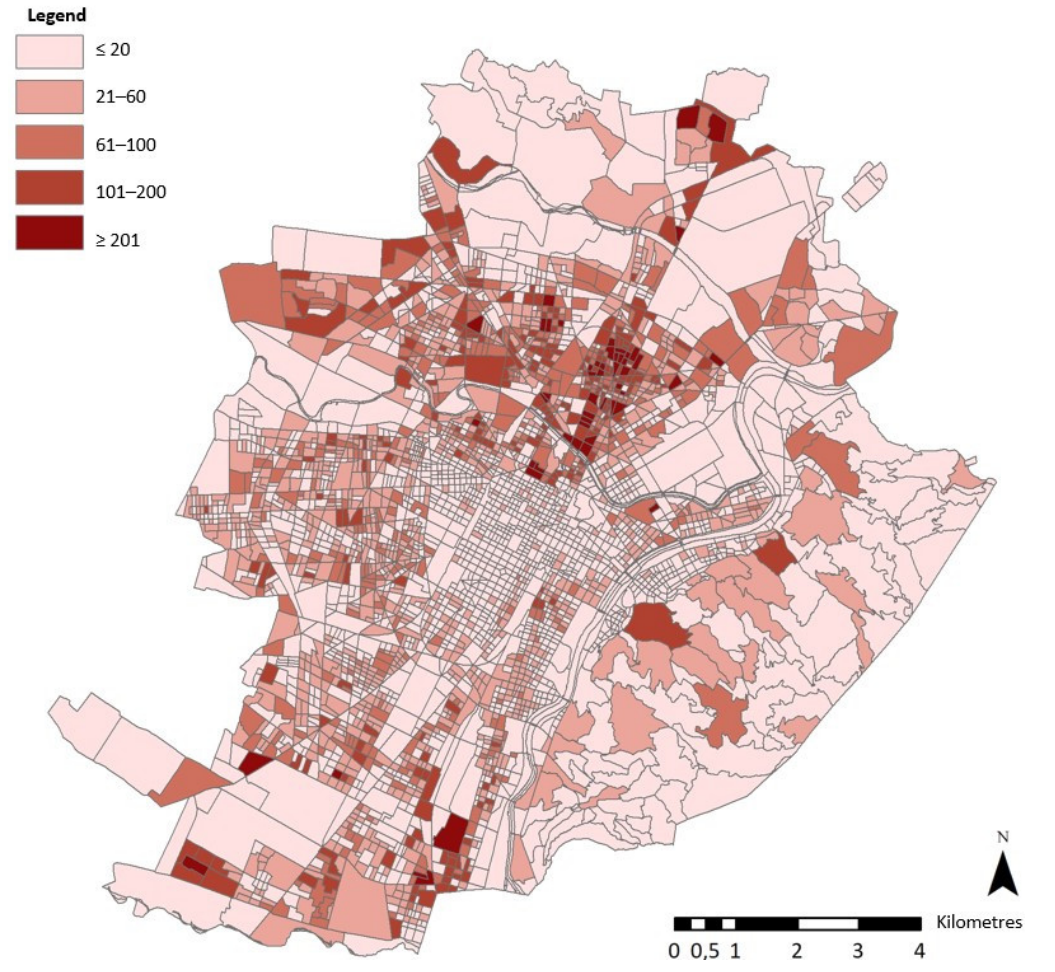
Figure 8. Foreign resident population, year 2020 [29].